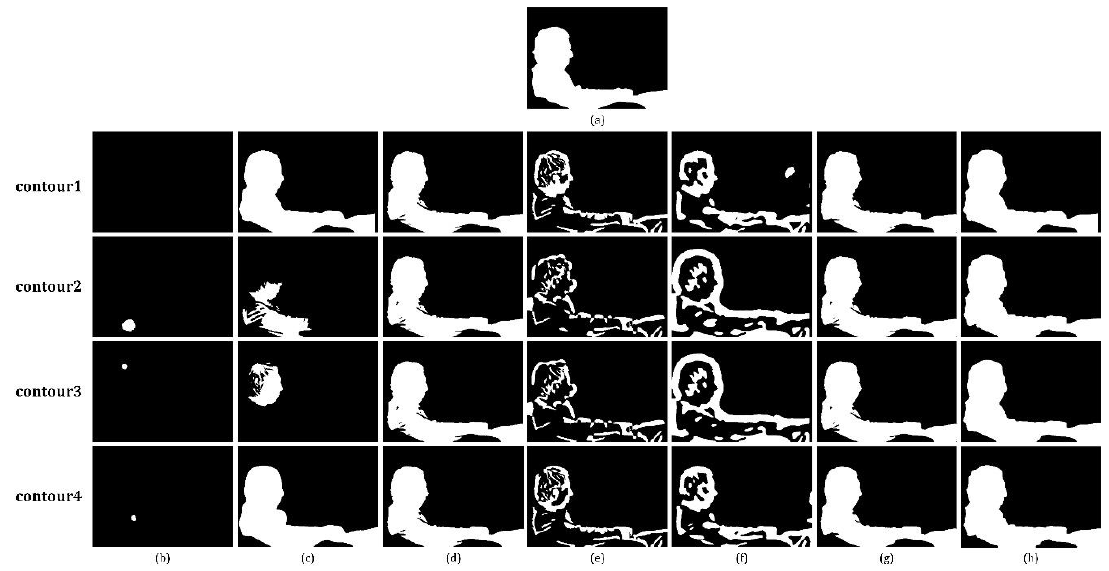
Figure 18. Binary segmentation results of ‘man’ image: ( a ) ground truth; ( b ) GAC; ( c ) CV; ( d ) SBGFRLS; ( e ) LBF; ( f ) ILFE; ( g ) Cao’s model; ( h ) the proposed method.